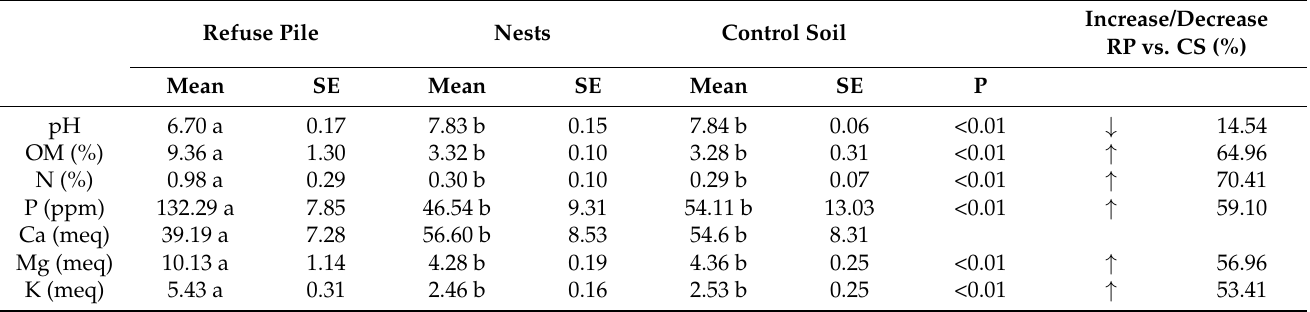
Table 2. Chemical properties (mean and standard error, SE) of soils collected from P. fallax ( n = 7) nests, refuse piles, and control soil from rehabilitated sites of the Cerrej ó n mine, located in La Guajira, Colombia. The Kruskal–Wallis test was performed, along with post hoc comparisons using the Dunn test. An increase or decrease in the values for refuse piles (RP) with respect to the control soil (CS) is indicated as a percentage and with